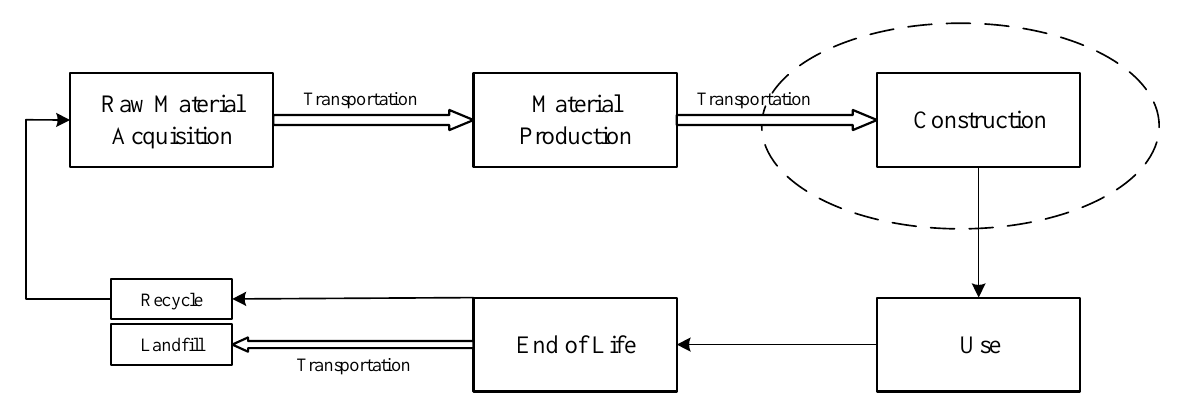
Figure 7. System boundary for SLCA.